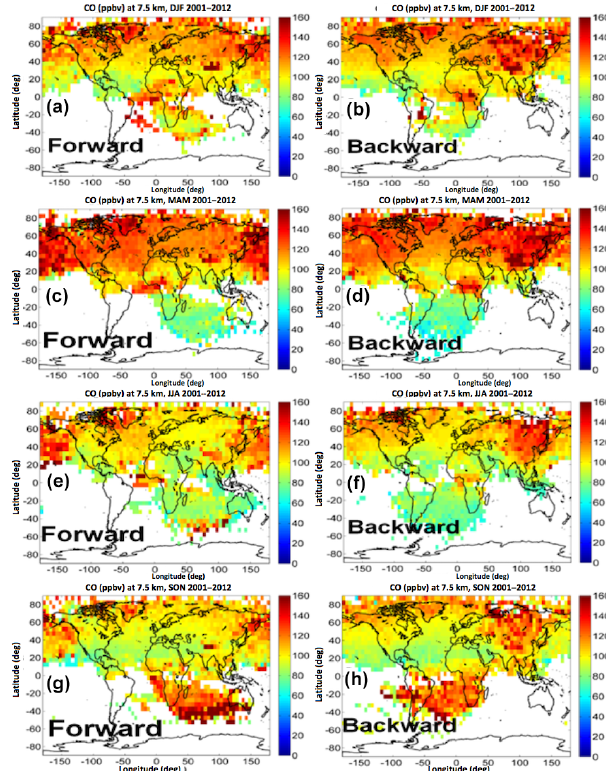
Figure 4. Examples of the global distribution, 2001–2012, of trajectory-mapped MOZAIC-IAGOS CO (ppbv) produced using only backward and only forward trajectories at 7.5kma.s.l. Pan- els correspond to different seasons: (a, b) December–February, (c, d) March–May, (e, f) June–August, and (g, h) September– November.